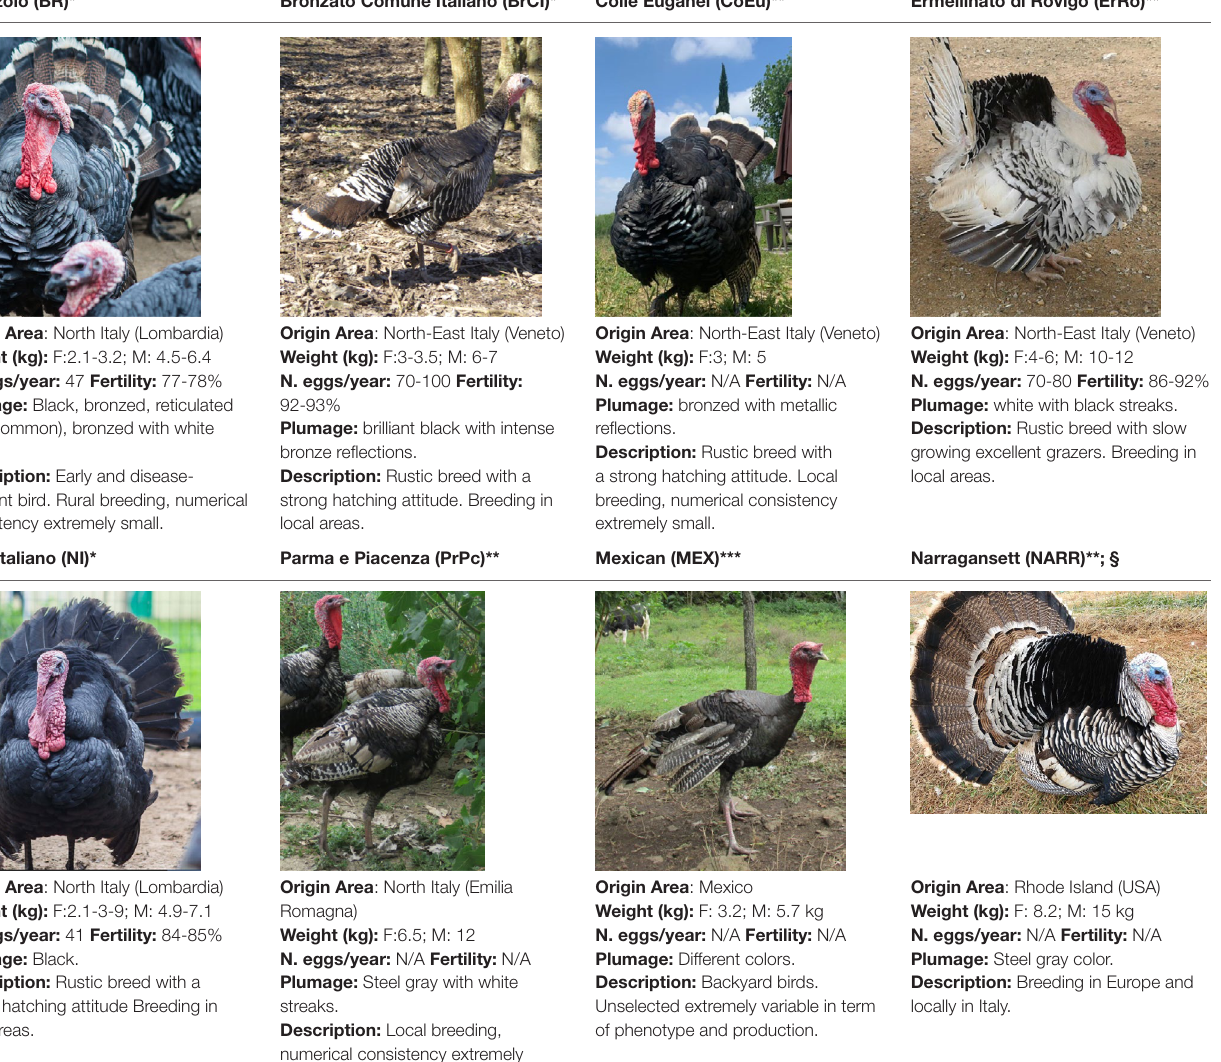
TABle 1 | Population name, sampling area, weight (kg) and plumage color of the turkey populations considered in the study. Brianzolo